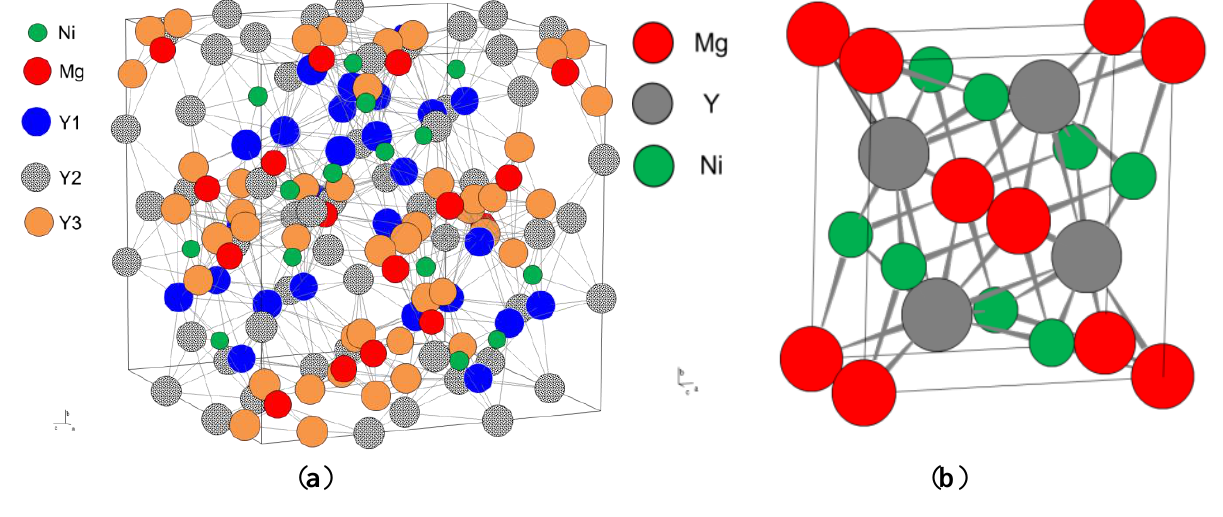
Figure 14. Unit cell for ( a ) τ 1 and ( b ) τ 2 .